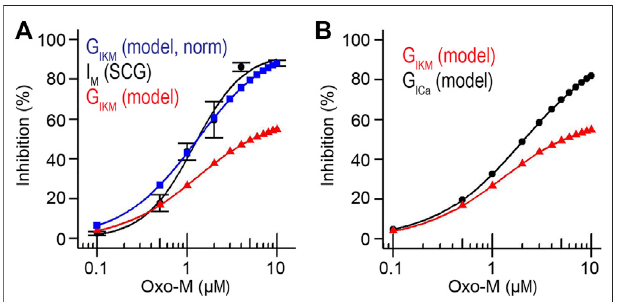
FIGURE 4 | Dose-dependence of I KM and I Ca inhibition. (A) . Simulated and measured inhibition of KCNQ2/3 channel activity in response to 0.1 – 10.0 μ M Oxo-M. Measured I M data for SCG neurons taken from (Kruse et al., 2016). (B) . Simulated inhibition of KCNQ2/3 and L-type calcium channels in response to 0.1 – 10.0 μ M